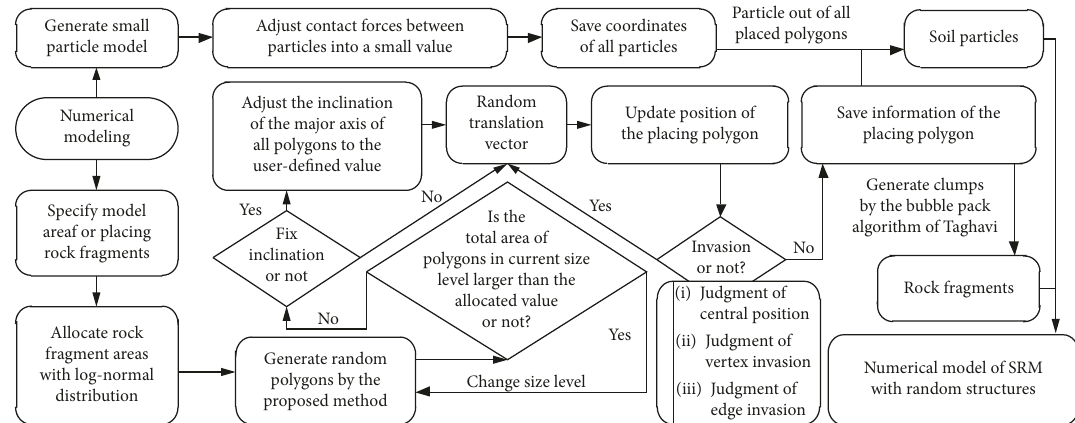
Figure 4: Flow chart of random structure modeling of SRM.